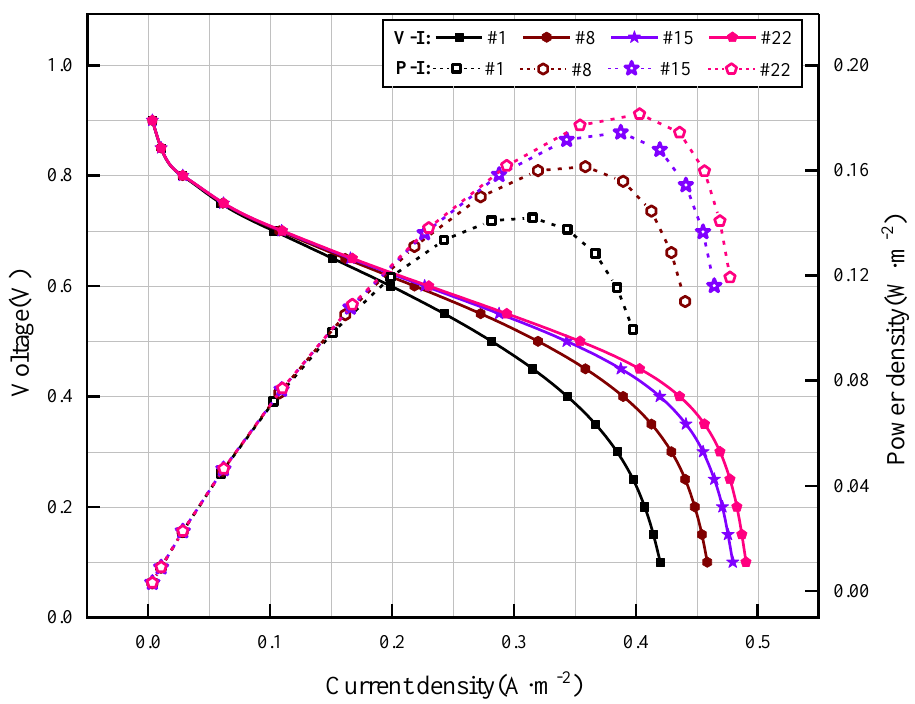
Figure 13. The polarization curves and power density curves between scheme #1, #8, #15 and #22. The influence of the number of layers on each scheme was also mainly reflected at the intermediate and high current densities. In these areas, the voltage increased accordingly with the growing number of layers. This is due to that the increase in the number of layers also effectively increasing the total area of the flow channels, which in turn promoted the full diffusion of the reactant gas into the MEA to participate in the electrochemical reaction; finally, resulting in an increase in the voltage of the fuel cell. Similar to the impact of changing the flow field structure on the fuel cell performance, the growth gap of voltages between four schemes became smaller with the continuous increase in layers. However, the difference between two key variables was that the gap of adjacent schemes with different layers could not be ignored. In the aspect of power density, increasing the number of layers has a positive effect on the improvement of the power density in the region with the intermediate and high current densities. Similarly, the magnitude of this growth was gradually diminishing. The comparison of the limiting current density and the maximum power density of four schemes in Figure 14 also conformed to the above variation characteristics. In a word, increasing the number of layers, such as increasing the number of polygonal sides, can change the interaction between the flow channel and the rib by increasing the area of flow channels, which in turn promoted the fuel cell to produce a greater voltage and power. In addition, increasing the number of layers also faced a gradual decrease in the growth rate. However, the difference between two key factors was that increasing the number of layers corresponded to a longer duration of the effective increase in the output voltage and power density of the fuel cell, and the floating range was higher when the interaction between the flow channel and the rib reached sta- bility.